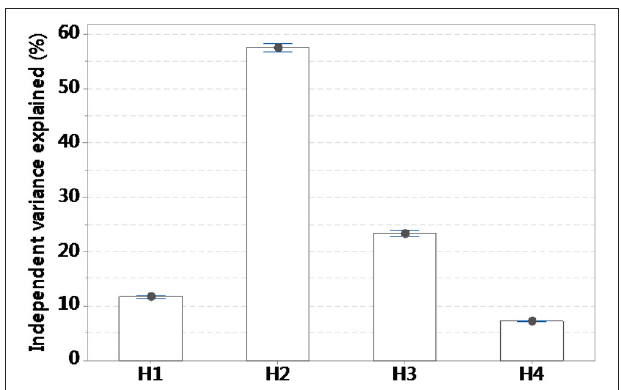
FIGURE 3 | Variance partitioning of environmental and habitat covariates included in each of four hypotheses. H1, propagule pressure hypothesis; H2, biotic resistance vs. acceptance hypotheses; H3, disturbance-mediated hypothesis; H4, environmental heterogeneity